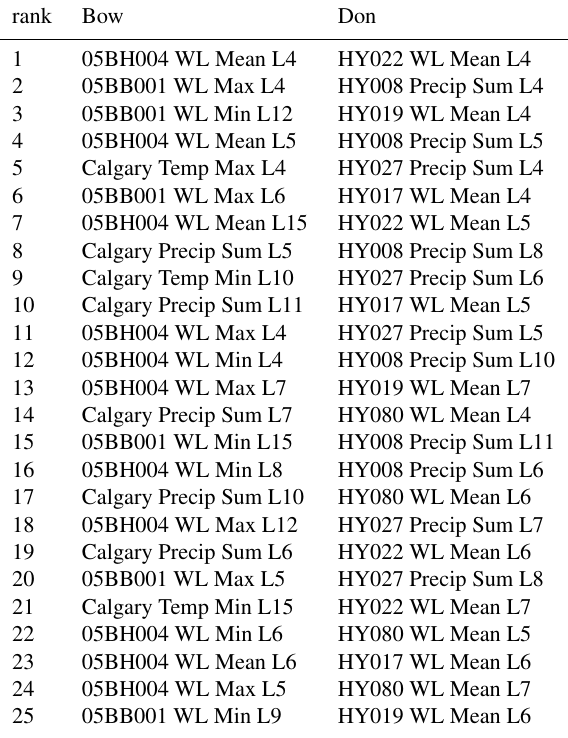
Table A1. List of the 25 most useful inputs identified using the PC IVS algorithm for the Bow and Don River watersheds, selected from the set of candidate inputs. Input variables are encoded in the following format: “station ID”_“variable”_“statistic”_“lagged timesteps”. Variable abbreviations “WL” and “Precip” refer to wa- ter level (stage) and